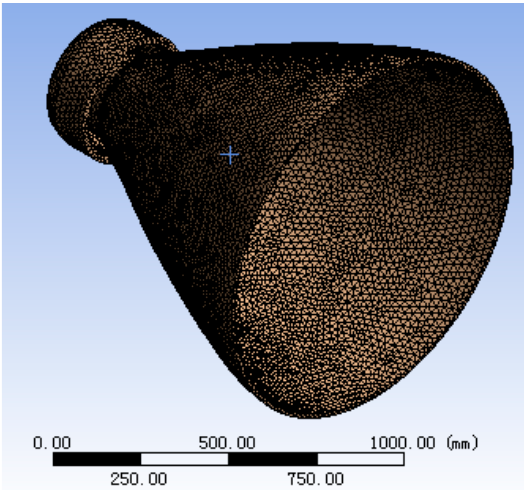
Figure 18. Nozzle structural grid.